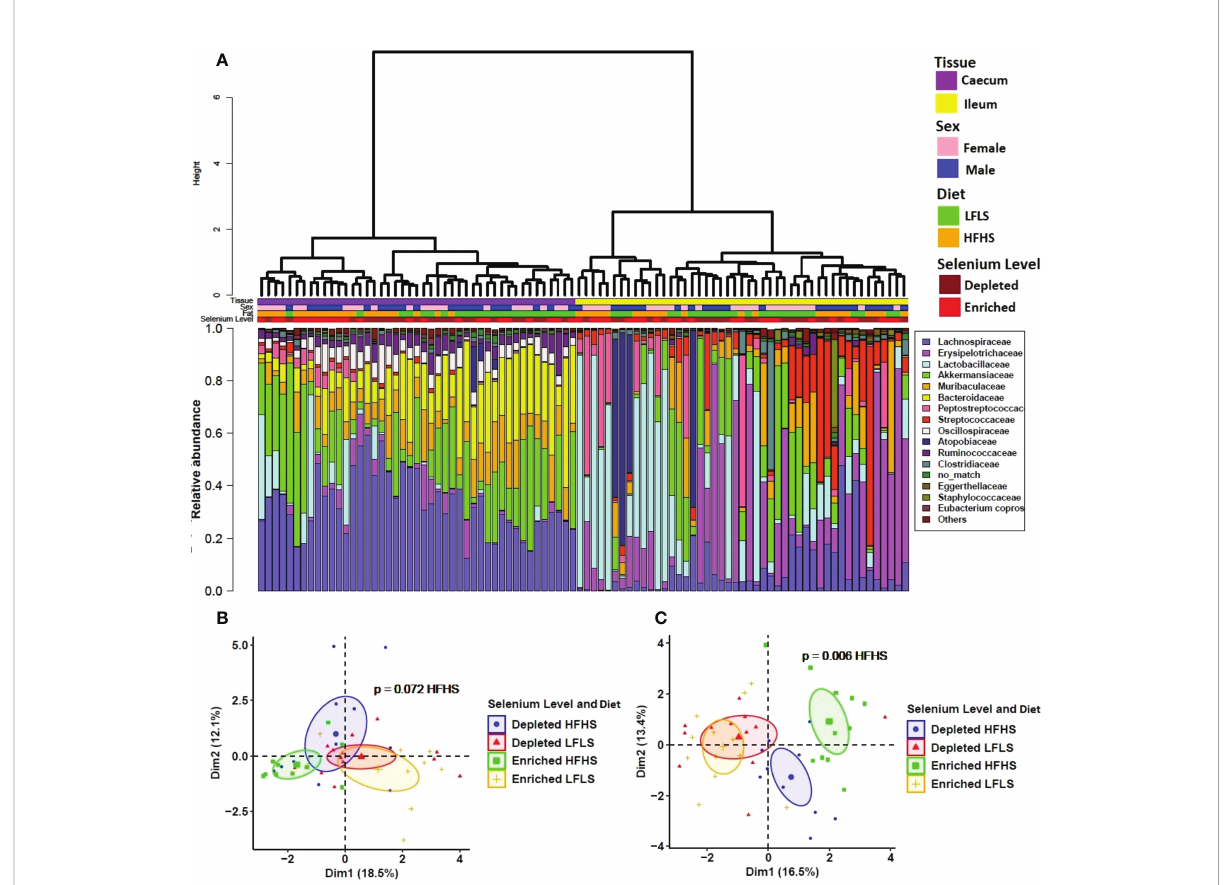
FIGURE 5 Intestinal microbiota composition in response to Se-enriched and Se-depleted LFLS or HFHS diets. A ) Relative bacterial abundance at the family rank in response to Se-enriched and Se-depleted LFLS or HFHS diets in the intestinal segments ileum and caecum. Families representing less than 1% of total bacterial abundance were aggregated. Dendrogram showing hierarchical clustering based on Canberra distance between samples is showed and determines the sample ordering. The corresponding annotations for tissue, sex, diet and Se level are displayed. B ) Principal component analysis shows the impact of depleted/enriched concentrations of Se with High and Low-Fat Sucrose diets on gut microbiota composition of the ileum and C ) in the caecum. Permanova indicates signi fi cance of microbiota composition differences between the dietary conditions. The samples were analysed at day 28 of the